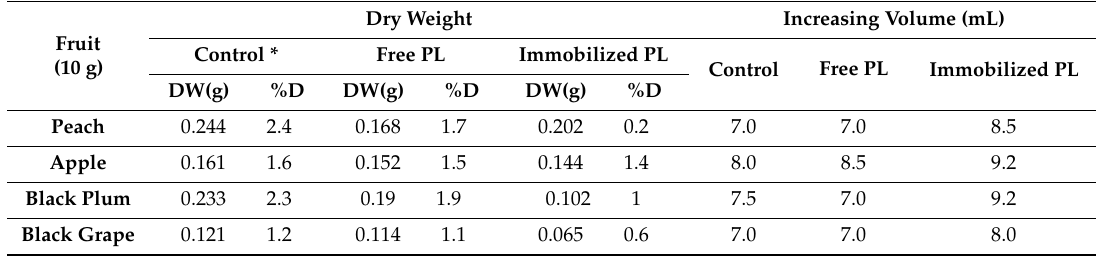
Table 3. Degradation rates of dry matter in fruits control, treated with free and immobilized pectin lyase (PL) enzyme. DW: dry weight %D: decrease